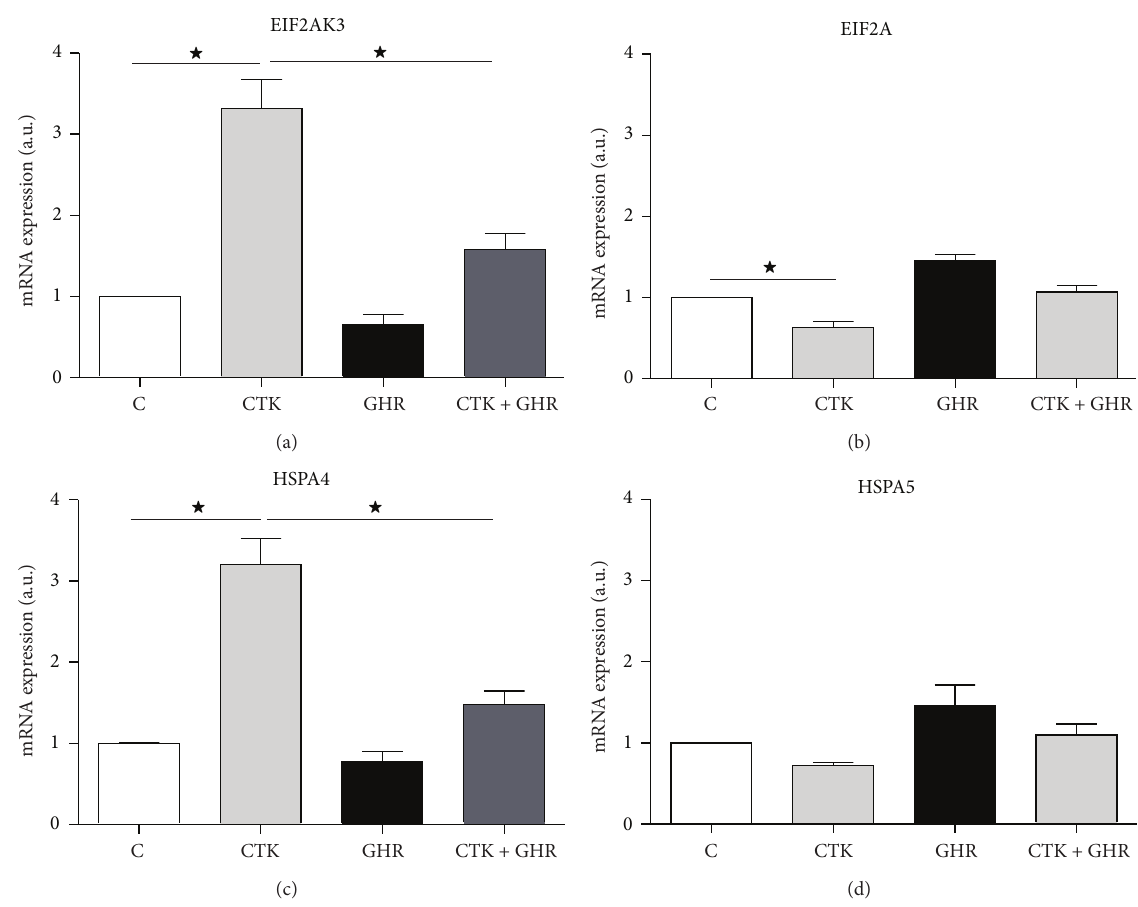
Figure 4: Ghrelin and cytokines’ effects on ER stress response markers. Real-time quantitative PCR reaction was performed to measure gene levels of EIF2AK3 (a), EIF2A (b), HSPA4 (c), and HSPA5 (d) in cytokines treated cultures alone or in presence of ghrelin. Results are presented as mean ± SEM of mRNA expression indicated as arbitrary units. Values were obtained from 4 independent experiments. * 𝑝 < 0.05 between groups. C, control; CTK, cytokines; GHR, ghrelin; CTK + GHR, cytokines + ghrelin.